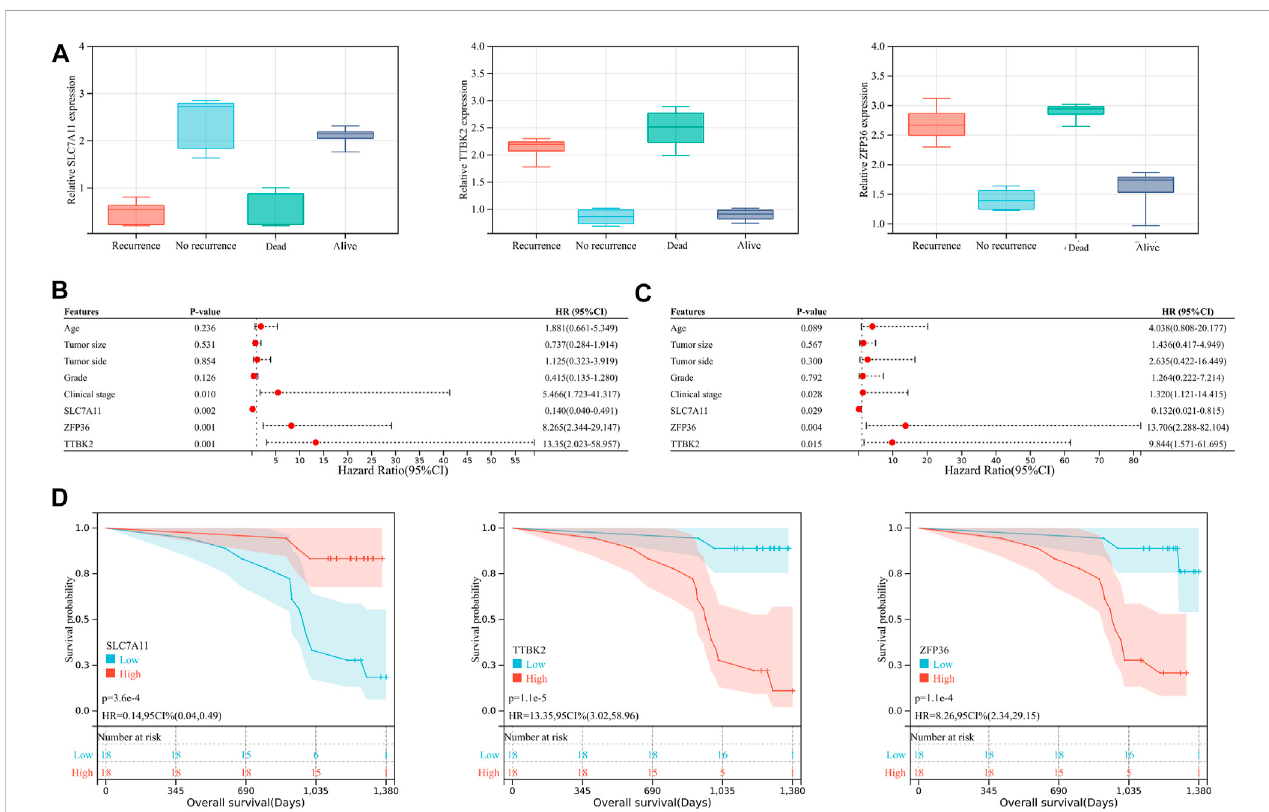
FIGURE 6 The ferroptosis-related genes predict prognosis in ovarian cancer (OV) patients. (A) The expression of SLC7A11, ZFP36, and TTBK2 in the OV tissues, whichwasmeasuredbyqRT-PCRanalysis.Theforestplotofunivariate (B) andmultivariate (C) Coxregressionanalysis forOVpatientsurvival,basedonthe3- gene signature and clinical features. (D) The Kaplan-Meier (K-M) curves for OV patients, strati fi ed by the expression of SLC7A11, ZFP36, and TTBK2.